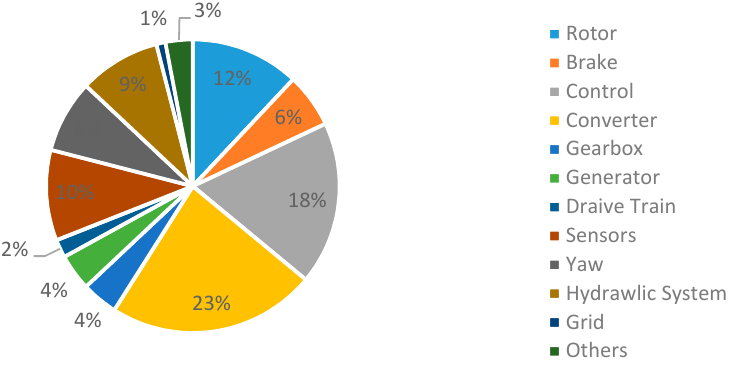
Figure 4. Failure rate within wind turbine components [18].